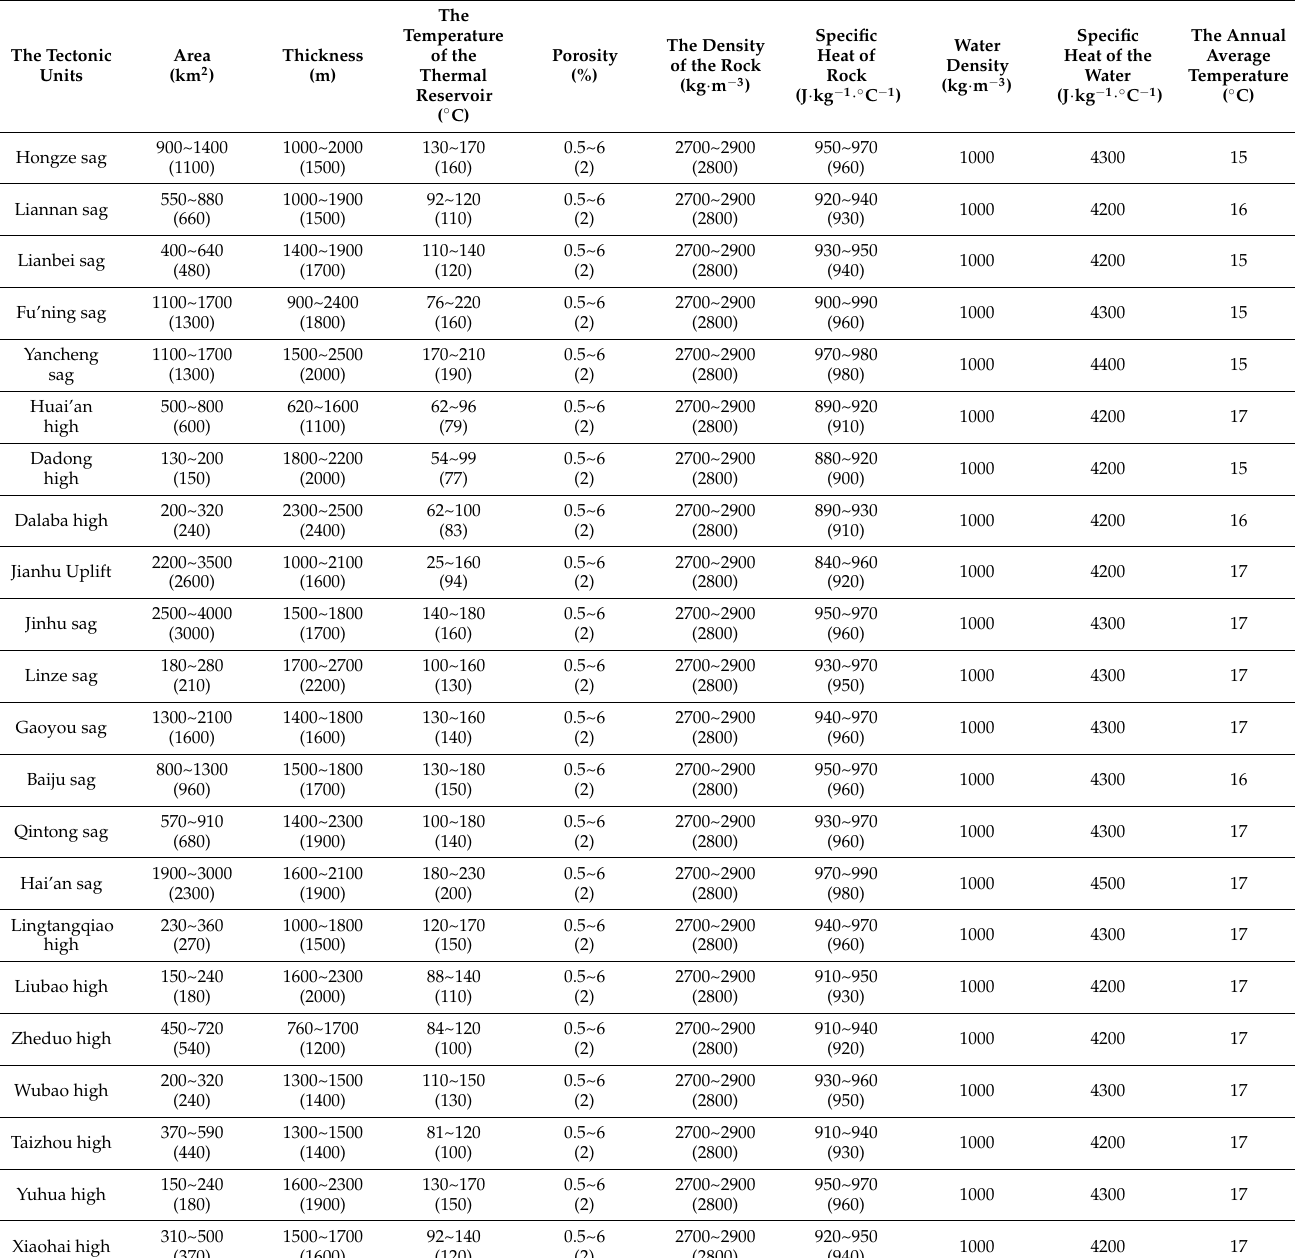
Table 5. Parameters for the carbonate thermal